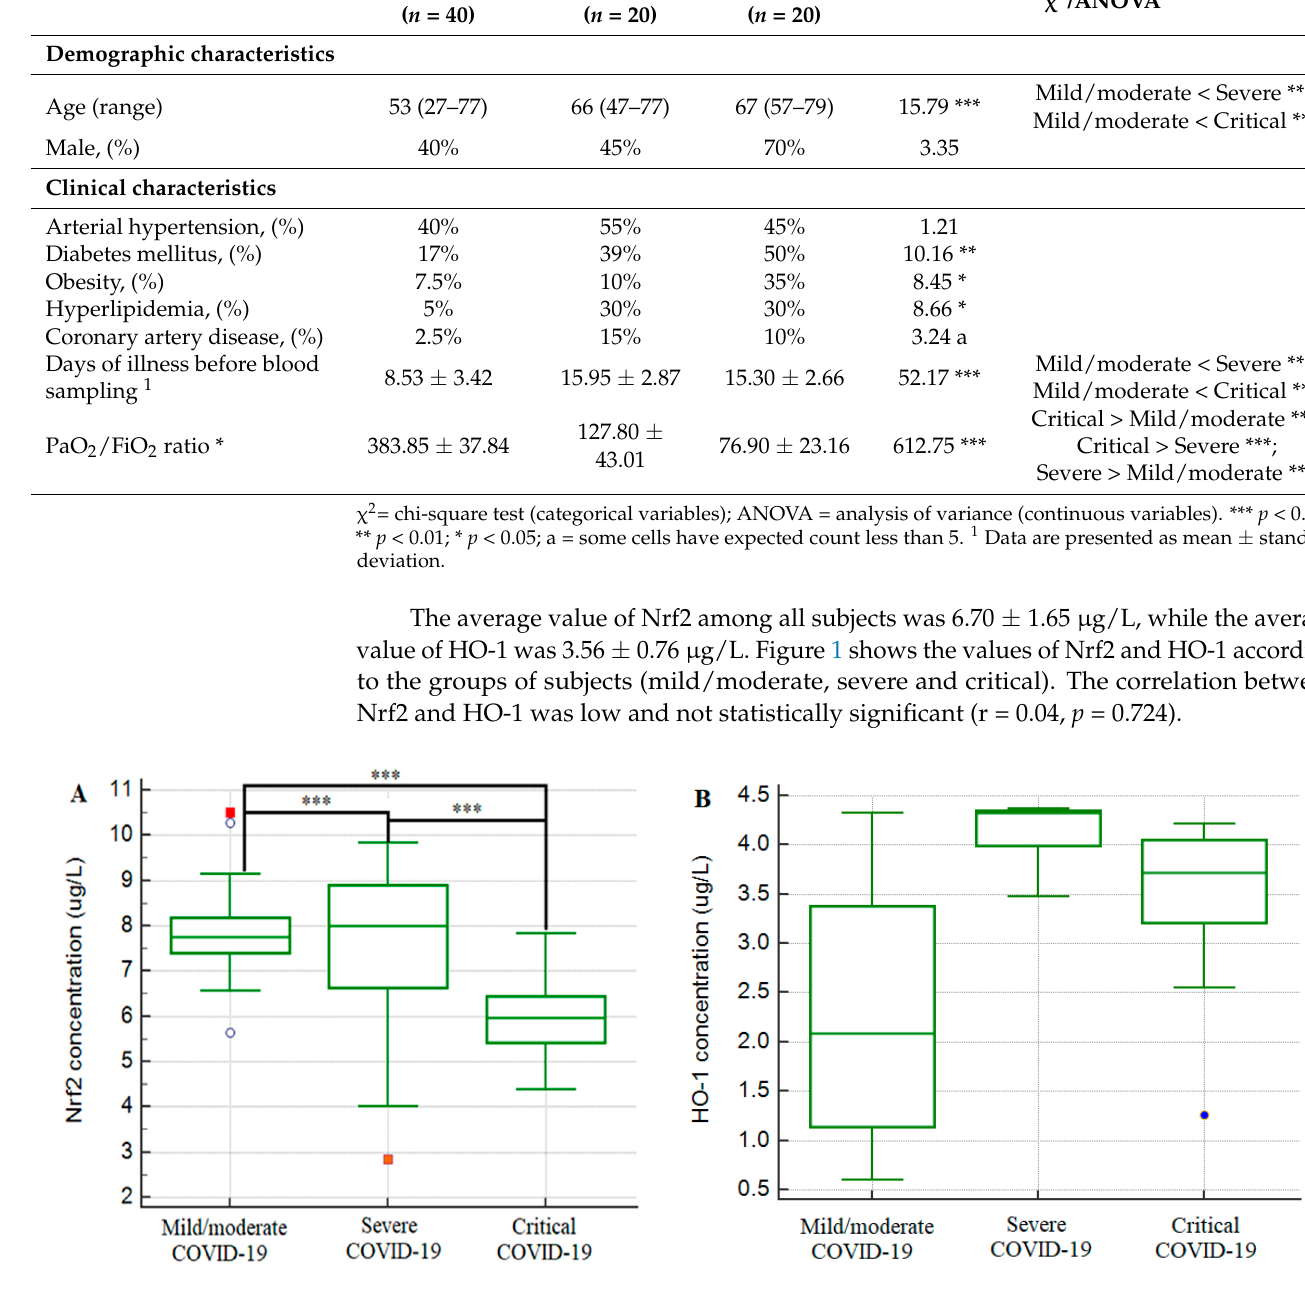
Figure 1. Serum concentrations of Nrf2 ( A ) and HO-1 ( B ) in patients with COVID-19 disease. *** p < 0.05. Table 2 . Correlation of concentration of Nrf2 and HO-1 with severity of the disease.